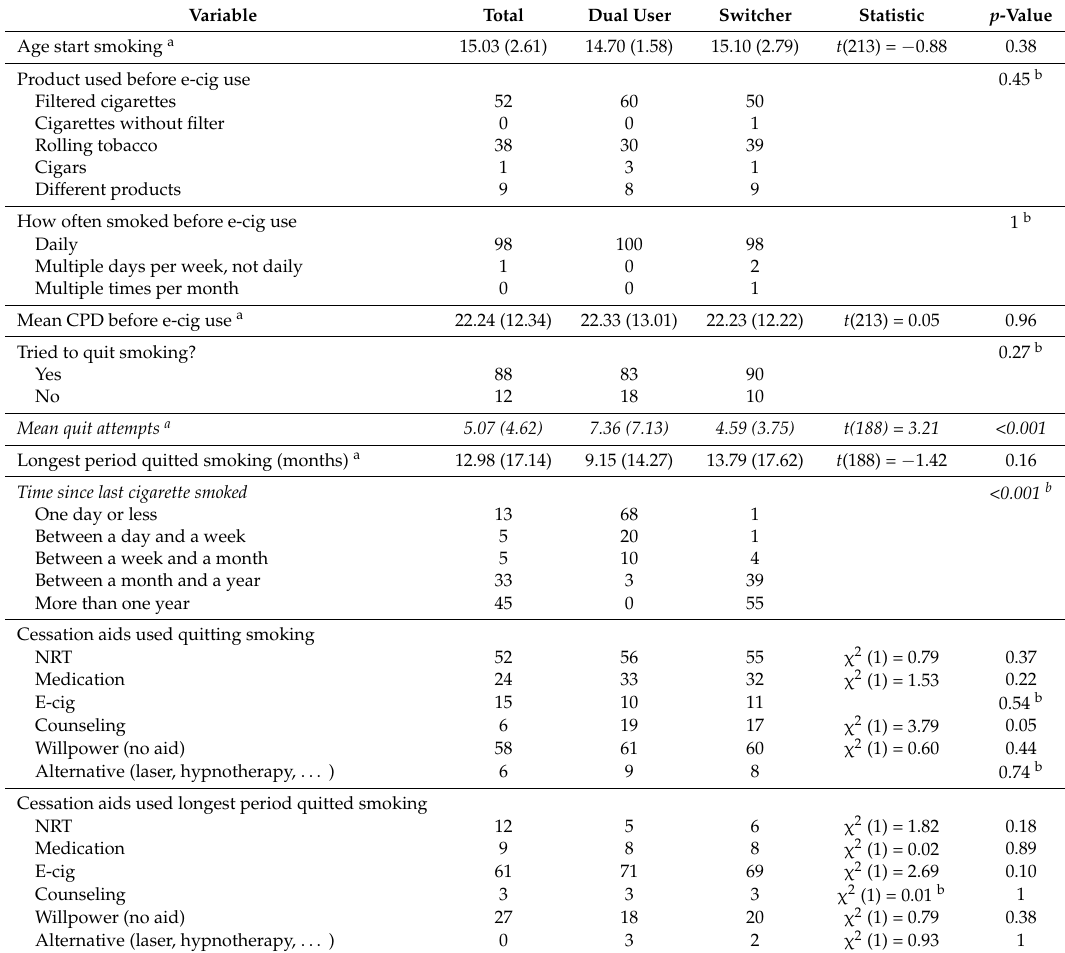
Table 2. Smoking history and current smoking behavior, smoking cessation history and aids used, Fagerström Test for Cigarette Dependence (FTCD), future plans